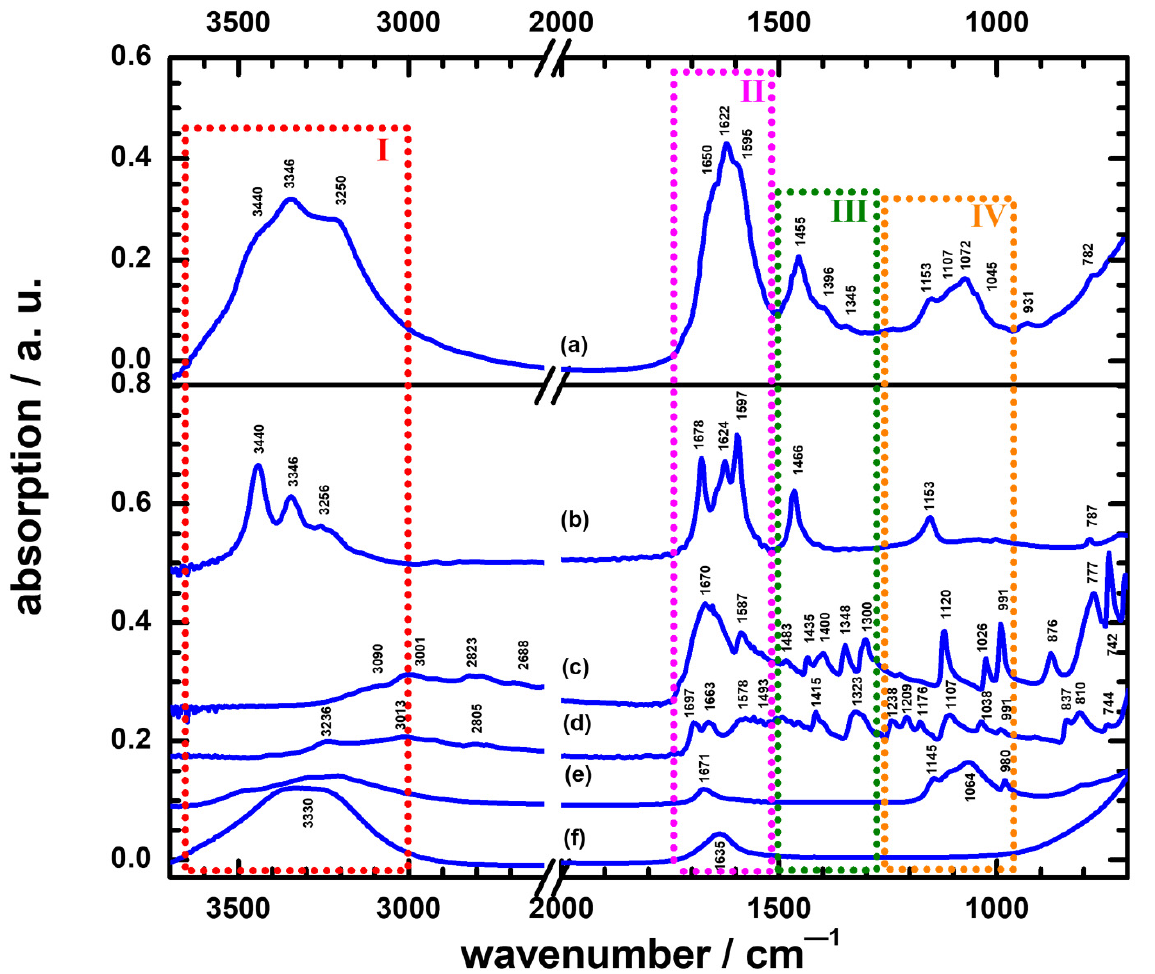
Figure 1. Infrared absorption spectra of: ( a ) averaged non-UTI designated as IR av/non ; ( b ) urea; ( c ) uric acid; ( d ) creatinine; ( e ) magnesium sulfate (MgSO 4 ·7H 2 O); ( f ) liquid water.